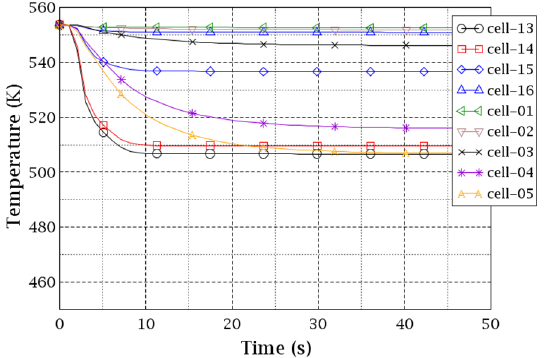
Figure 24. Evolution of the coolant temperature distribution at the core outlet of the AP1000 reactor CA-V hot-part (cell index is from Figure 21).